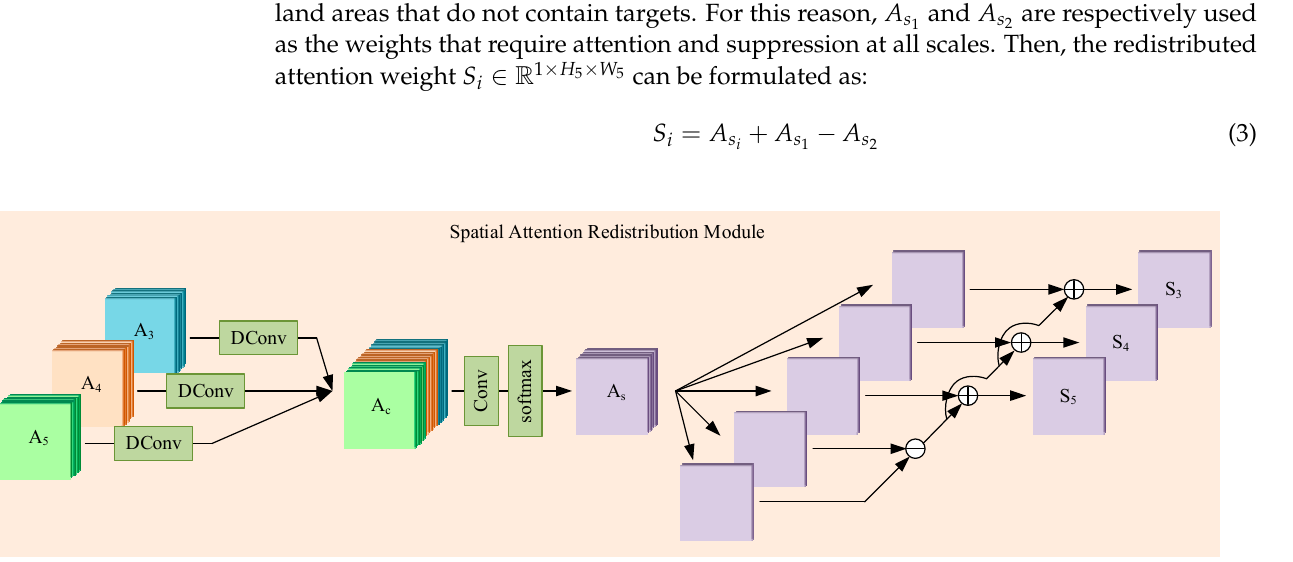
Figure 3. The structure of the spatial attention redistribution module.